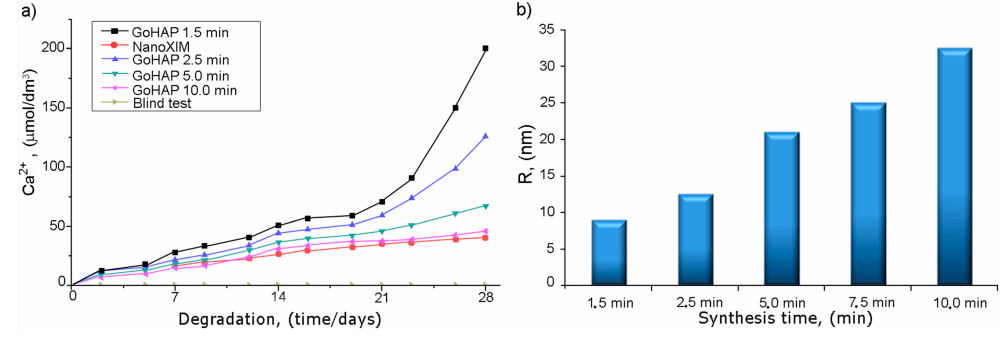
Figure 11. ( a ) Size/time effect on bio-degradability of HAP nanoparticles produced in the Magnum II reactor [24]; ( b ) Grain size, as a function of synthesis